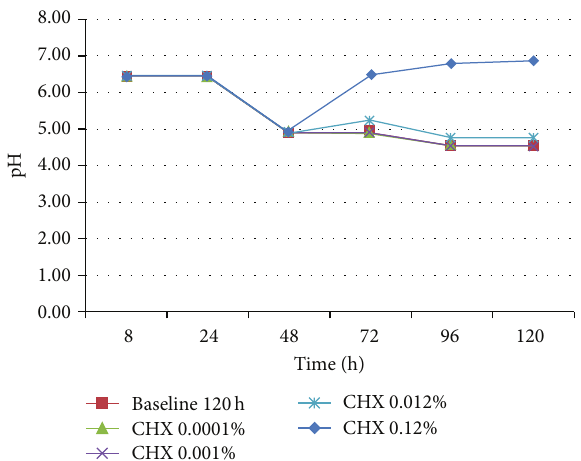
Figure5:pHoftheMHculturemediumafter48 hofbiofilmgrowth intheabsenceoftreatmentsandateach24 hafterstartingtreatments (72, 96, and 120h) ( 𝑛 = 4 ).